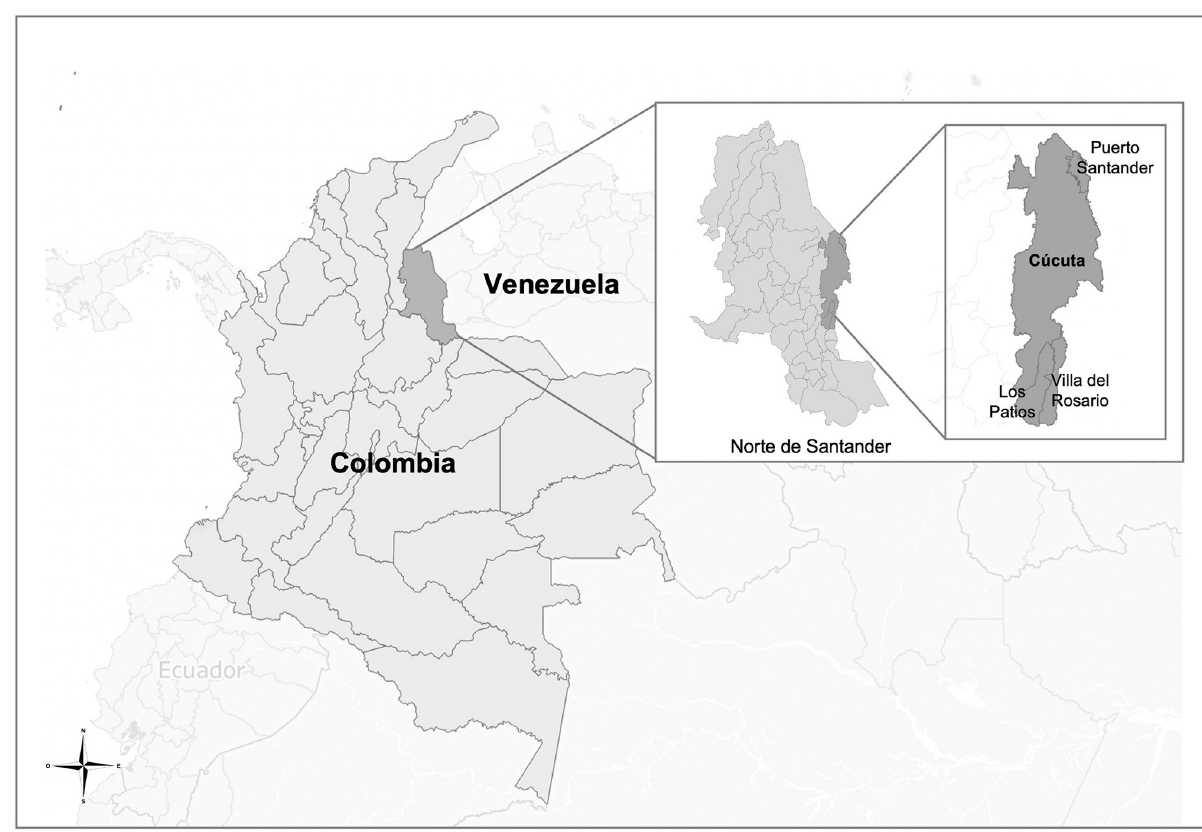
Fig 1. Location of Cu´cuta and the three municipalities of its metropolitan area where the study population was recruited.